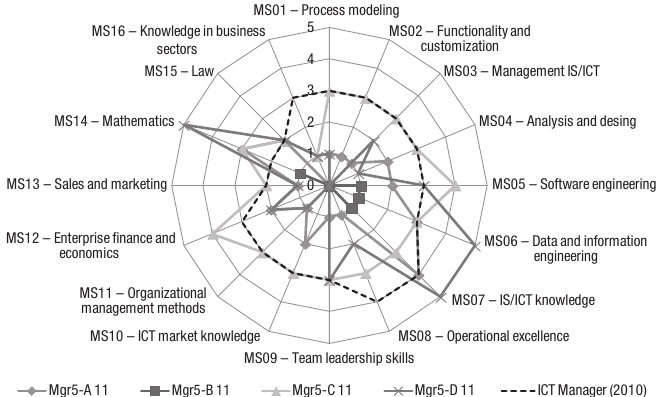
Fig. 6. Knowledge provided by master’s fields of study vs demand for knowledge by economic entities for the role of ICT manager in 2010. Source: